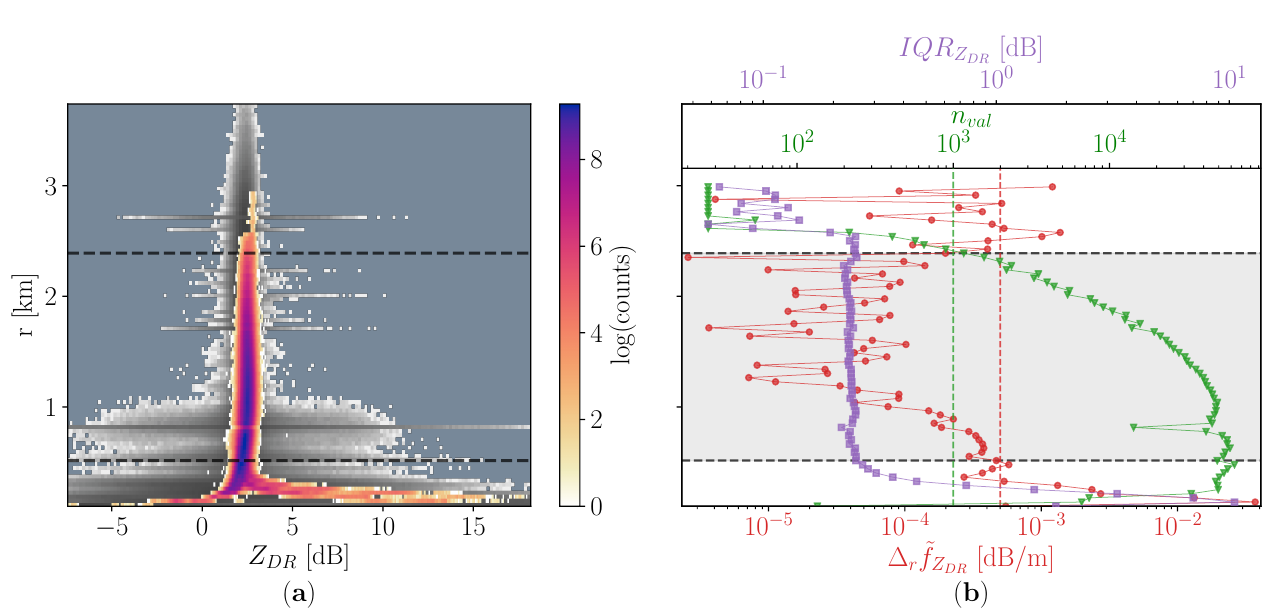
Figure 1. Filtering of the Plan Position Indicator (PPI) scans for the PAYERNE campaign: ( a ) The 2-dimensional histograms of the couples ( Z DR , r ) before (in grayscale) and after (in color) imposing the threshold on SNR H , SNR V , ρ hv and ml idx . The color scale shows the logarithm of the measurements counts per bin. ( b ) Plot of ∆ r ˜ f Z n val (in green) against r . The y-axis is shared between the two panels, while the color of the labels of the three x-axes shows the curve associated with it. The vertical dashed lines represent the thresholds on ∆ r ˜ f Z profiles selected at the end of Section 3.1 is shown as a gray shaded area, limited by two horizontal, black, dashed lines. The same lines are shown in panel ( a